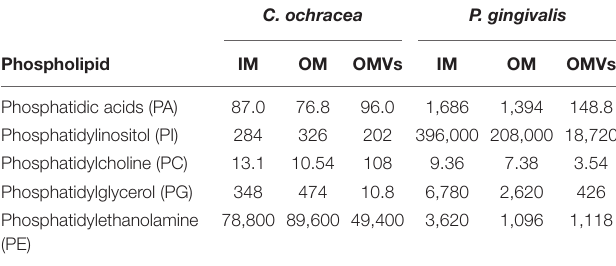
TABLE 1 | Phospholipid contents of purified IM, OM, and OMVs